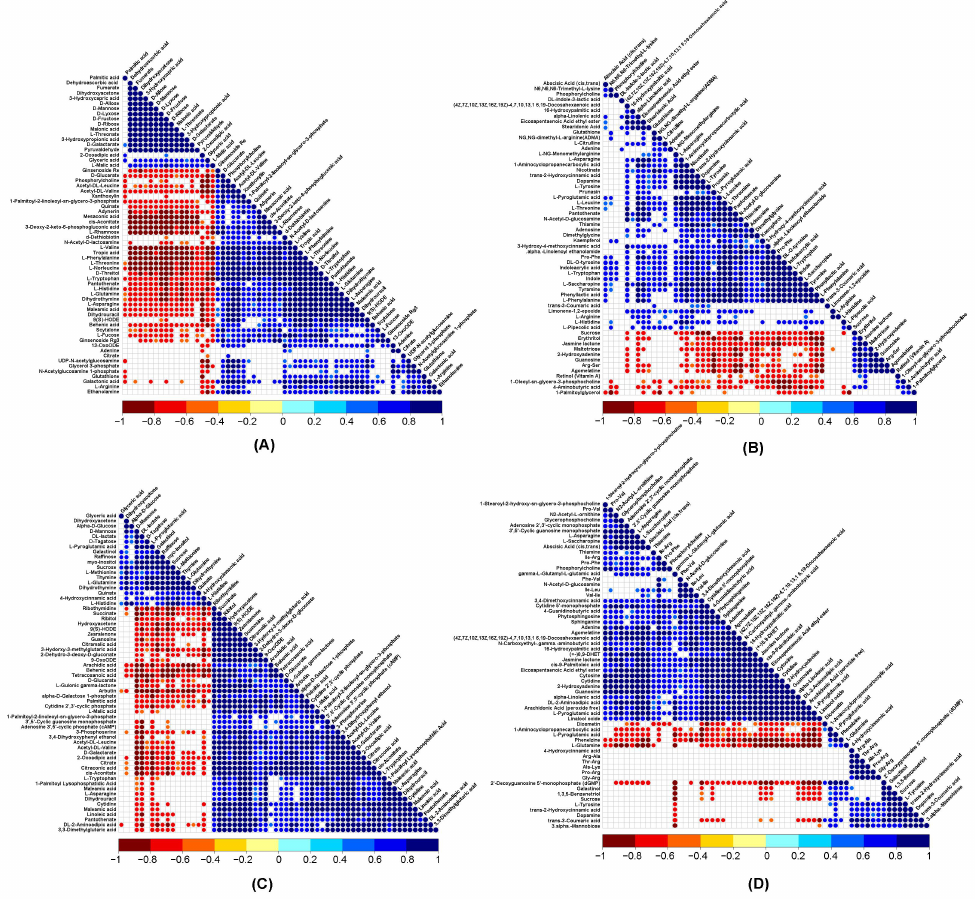
Figure 4. Pairwise correlation heatmap among differentially expressed metabolites of ginseng leaves and ginseng stems in negative ( A , C ) and positive mode ( B , D ). 1 and −1 depict the highest negative and positive correlation values, respectively, in the correlation matrix.